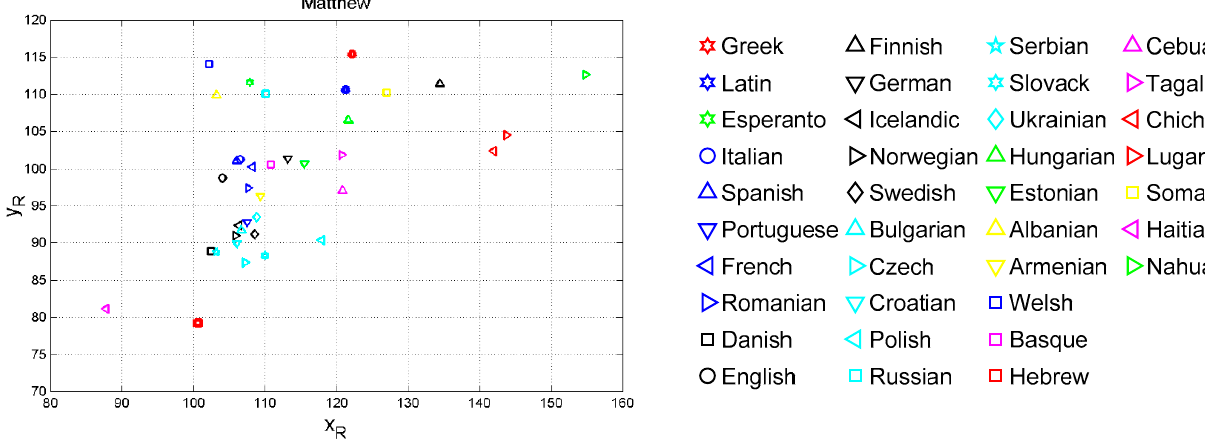
Figure 3. Distance 𝑑 from Matthew according to the language indicated in abscissa. The order of languages is the same as in Table 1. Greek (language no.1) is at 𝑑 (cid:3404) 0 ; Latin (2) at 𝑑 (cid:3404) 5 ; English (10) at 𝑑 (cid:3404) 25 , etc. In other words, for the purpose of being specific in deriving the full characteristics of the extended theory, it is sufficient to consider only Matthew and its translations, to show how a text is mathematically related, within the same language, to other texts, namely, in the following, the gospel according to Mark (Mk), Luke (Lk) and John (Jh), and to Acts (Ac) and Apocalypse (Revelation) (Ap). Moreover, of the many linguistic channels linking two texts, for brevity we consider the channel that links their sentences, discussed in the next section.